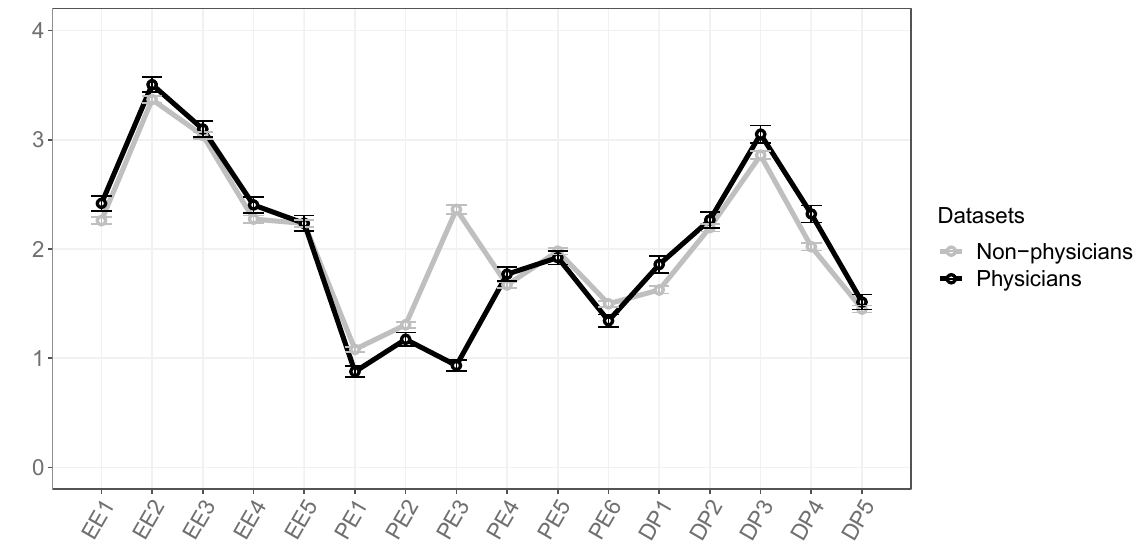
Figure 1. Mean burnout symptoms of physicians and non-physicians.